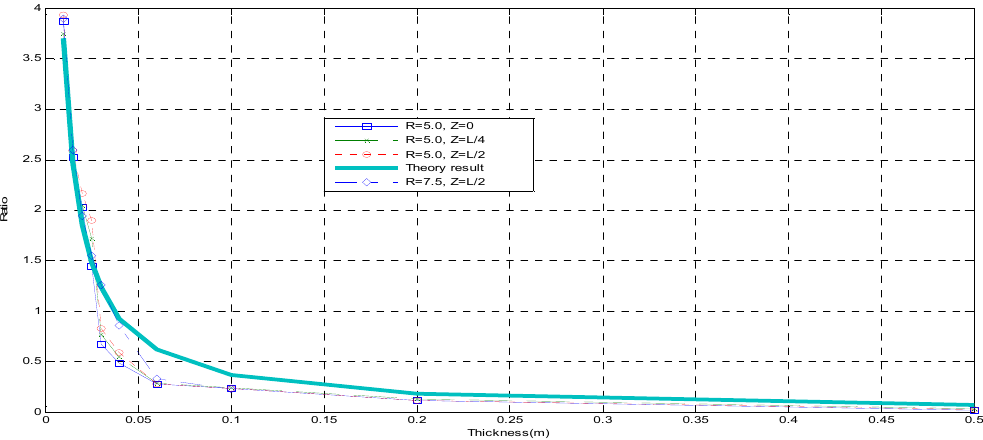
Figure 29. Plot of ratio vs. thickness when x = 0.